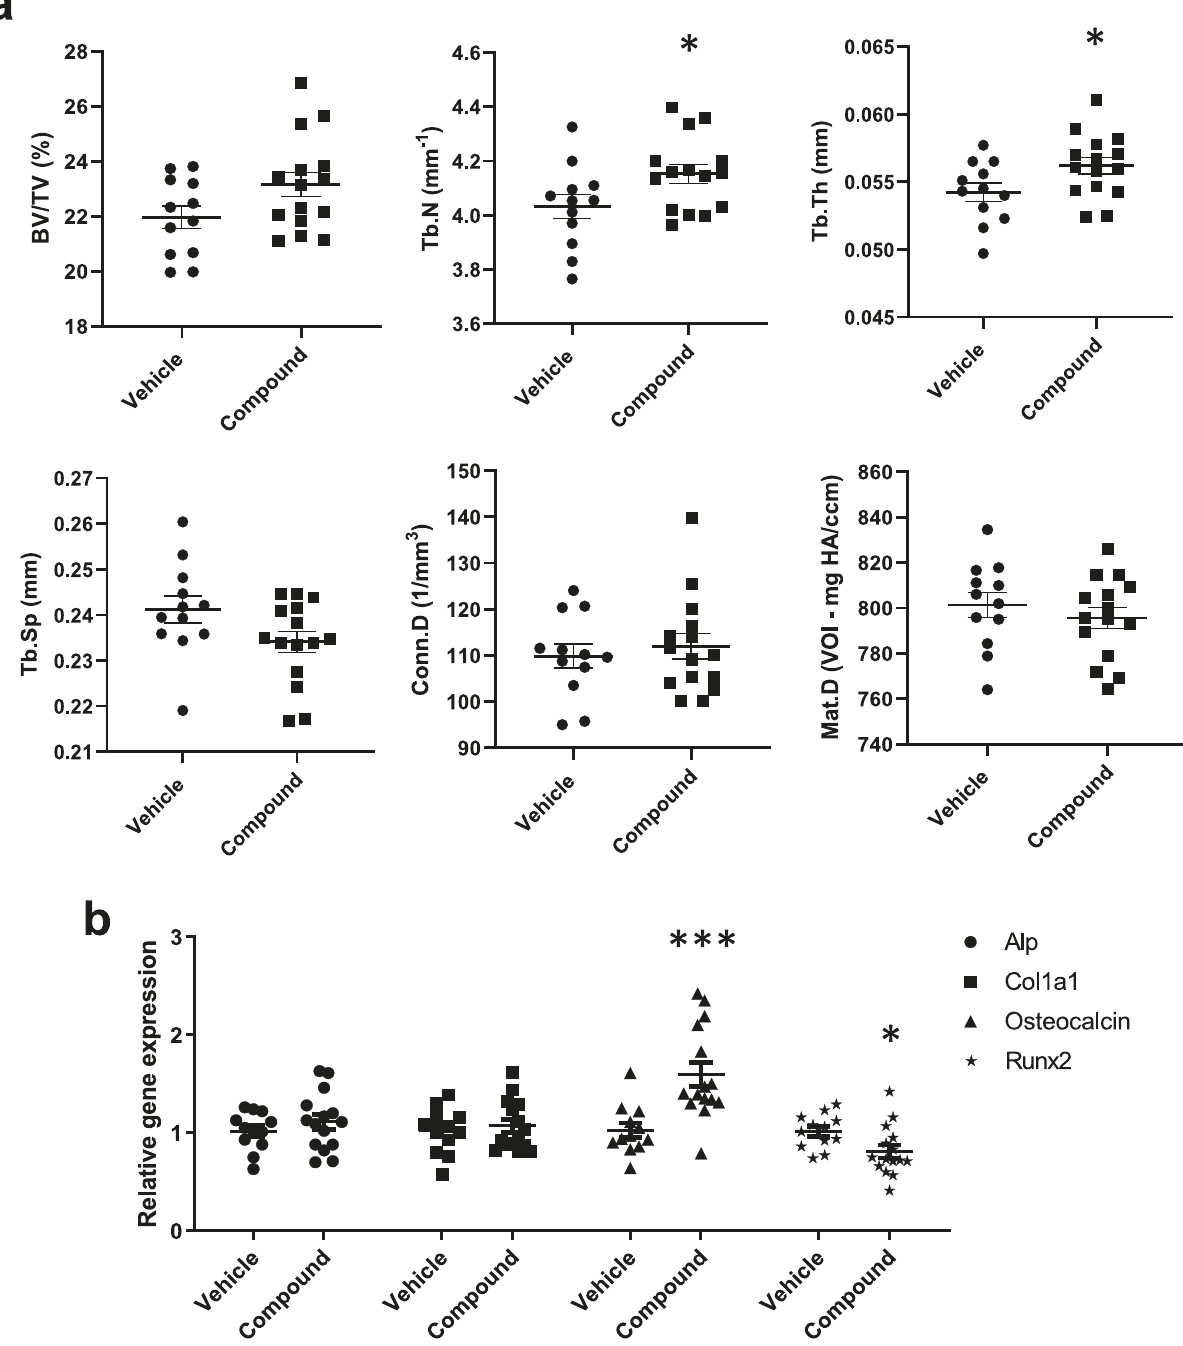
Fig. 5 Compound 6641 treatment increases bone formation in female mice. a Trabecular micro-CT parameters in lumbar vertebrae of vehicle- and compound-treated female mice. b Gene expression levels of osteoblast markers in tibias from vehicle- and compound-treated female mice measured by quantitative RT-PCR. Twelve and fi fteen mice were used in the vehicle and compound groups respectively. qRT-PCR data are normalized to control group and expressed as mean ± SEM. * p < 0.05, *** p < 0.001 vs. vehicle using Student ’ s t